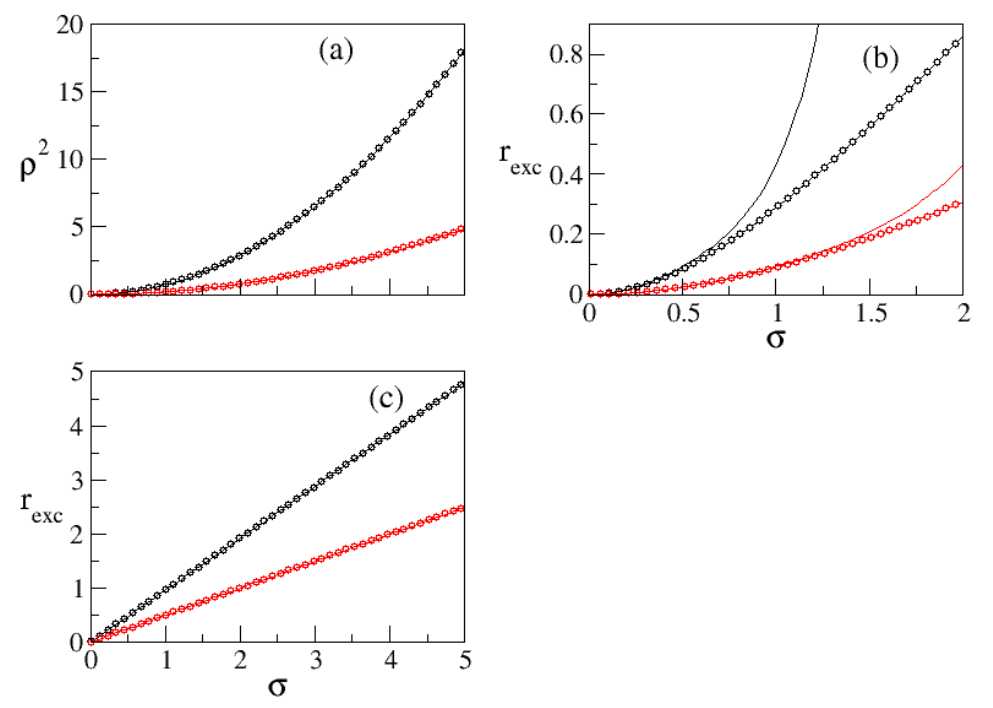
Figure A2. ( a ) The rms local slope, ρ , as predicted by Equation (A22) as functions of variance, σ , for the cases of ξ = 5 (black curves and symbols) and ξ = 20 (red). ( b ) A comparison between the analytic approximations of Equation (A23) (first three terms, solid lines) and the “exact” values of the excess relative surface area, r exc ≡ r w − 1 as functions of σ with the same labeling. The “exact” values were obtained by averaging over a thousand realizations of the surface and the area was computed in a “continuous” approximation as explained in the main text. ( c ) The same thing but treating the surface as being made up of discrete plaquettes for both the analytic approximation, Equation (A25), and in computing the area of the simulated